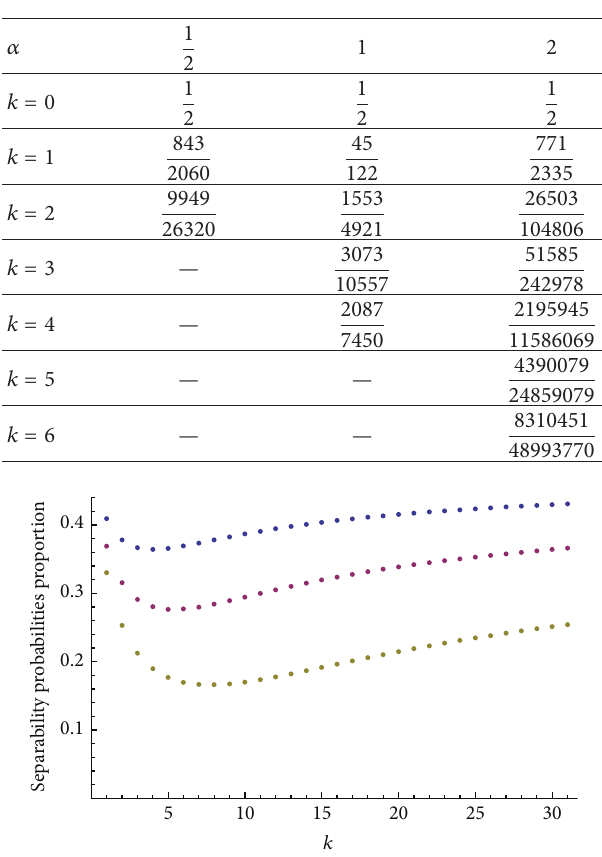
Table 4: Proportions of total separability probabilities |𝜌 PT | > |𝜌| .